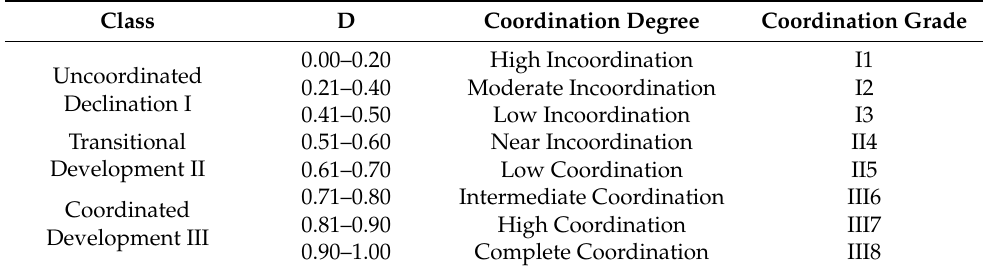
Table 2. Coupling coordination level classification criteria.